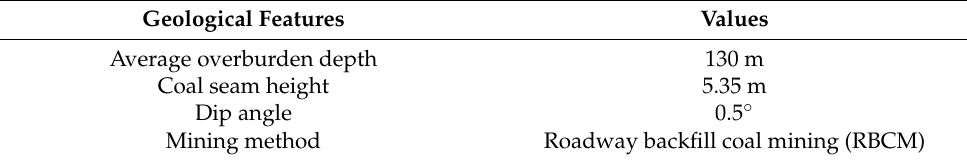
Table 2. Geological features of the